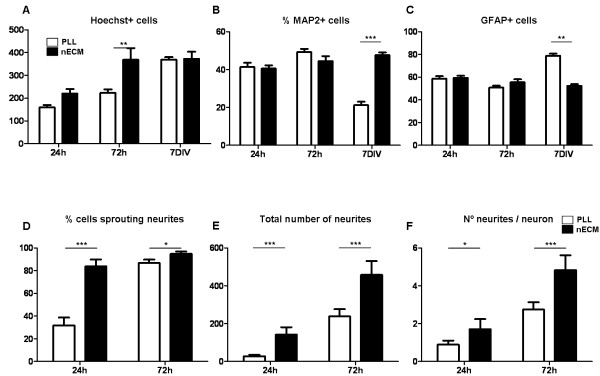
Quantitative assessment of hippocampal neuronal and glial differentiation on PLL- and nECM-coated coverslips. (A-C) To estimate the total cell number in each photograph, the number of nuclei stained by Hoechst was counted (A) and the percent of cells positive for MAP2 (B) and GFAP (C) immunostains were determined. (D-F) Focusing on MAP2 positive cells, the number of cells sprouting neurites (D) as well as the total number of neurites (E) was determined at 24 and 72 h, respectively. Next, the number of neurites per neuron was calculated (F). At least six different fields out of three independent experiments were quantified at each substrate and time point. Statistical analyses were done by using two-way ANOVA followed by Bonferroni’s posttests (*P < 0.05; ** P < 0.01; *** P < 0.001).